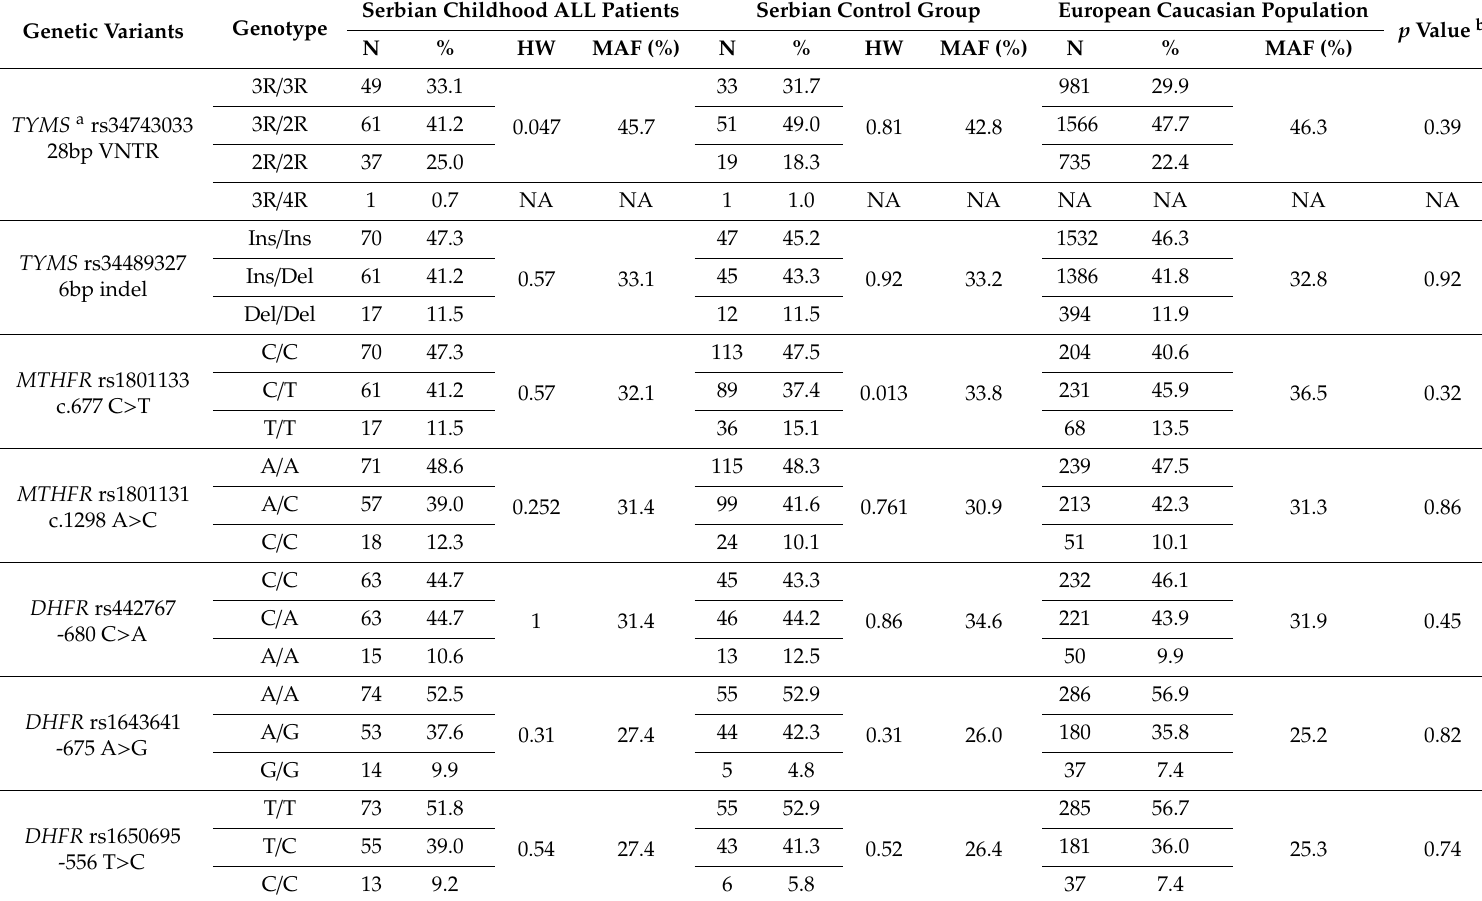
Table 1. Folate pathway genetic variant frequencies of Serbian acute lymphoblastic leukemia (ALL) patients, the Serbian control group and the European descent control group. For the European control group, data were extracted from 1000 genome project for variants in all genes of interest except thymidylate synthetase ( TYMS ). Frequencies of TYMS variants in European population was estimated from British, American, Italian and Portuguese Caucasians